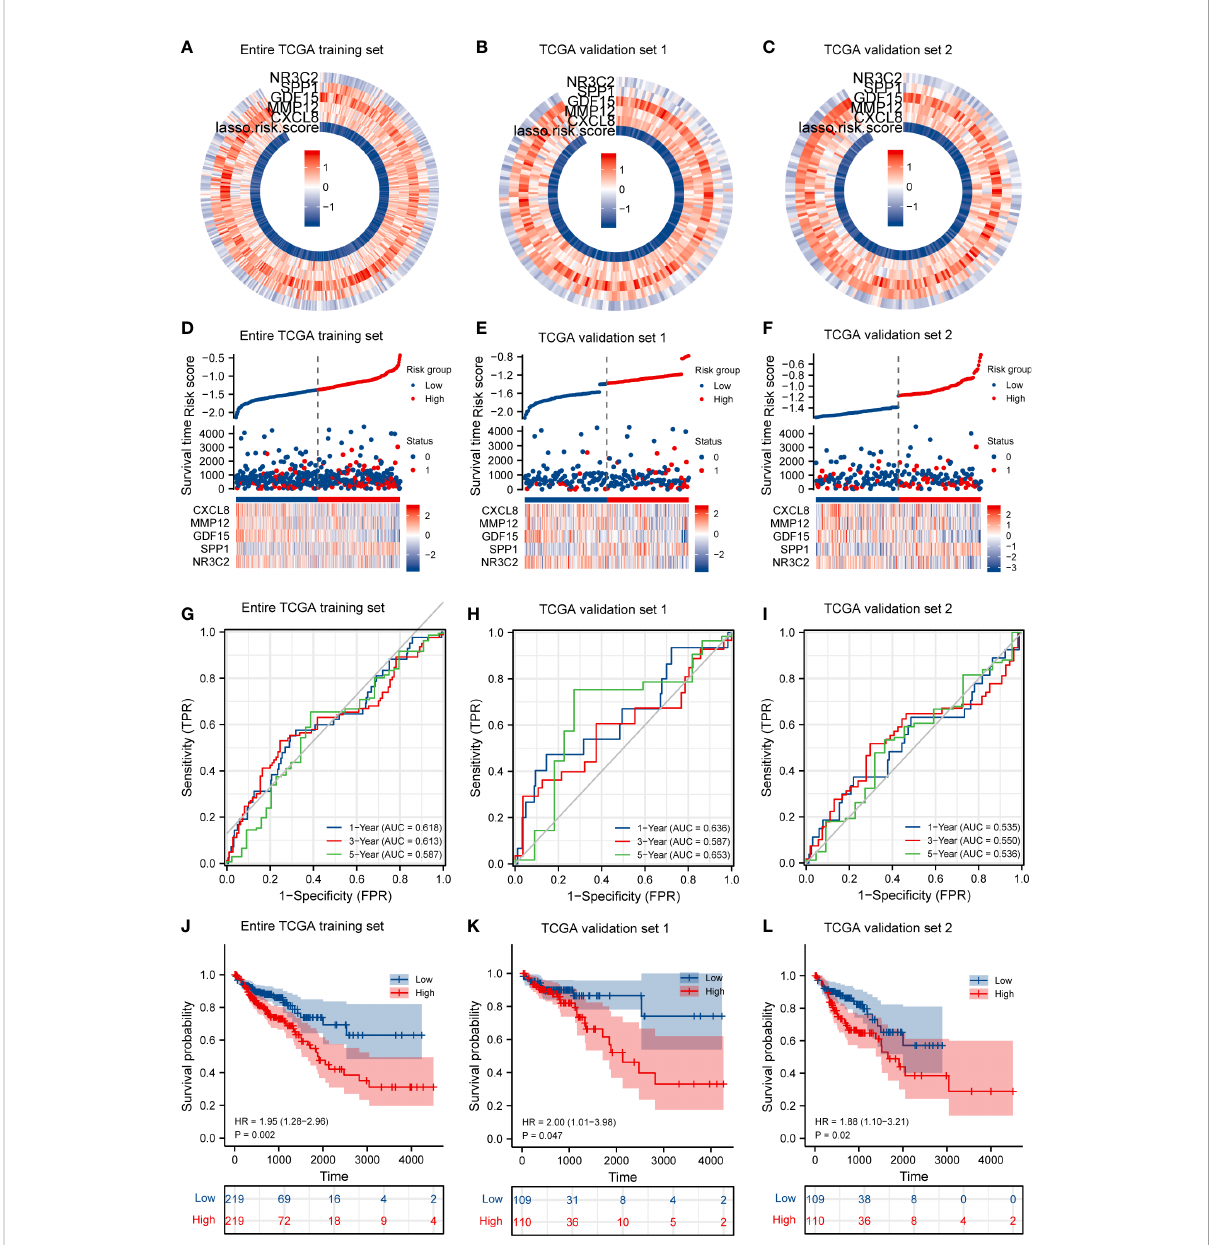
FIGURE 4 IRGPI accurately predicts survival of CRC patients and risk score validation. (A) Risk score and expression of fi ve DEGs in the TCGA training set. (B) Risk score and expression of fi ve DEGs in TCGA validation set 1. (C) Risk score and expression of fi ve DEGs in TCGA validation set 2. (D) Risk score distribution, survival status, and expression of fi ve IRGs for patients in low- and high-risk groups in the TCGA training dataset. (E) Risk score distribution, survival status, and expression of fi ve IRGs for patients in low- and high-risk groups in TCGA validation set 1. (F) Risk score distribution, survival status, and expression of fi ve IRGs for patients in low- and high-risk groups in TCGA validation set 1. (G) Time-dependent ROC curve analyses of risk score in the TCGA test set. (H) Time-dependent ROC curve analyses of risk score in TCGA validation set 1. (I) Time- dependent ROC curve analyses of risk score in TCGA validation set 2. (J) Risk score and survival probabilities in the TCGA test set. (K) Risk score and survival probabilities in TCGA validation set 1. (L) Risk score and survival probabilities in TCGA validation set